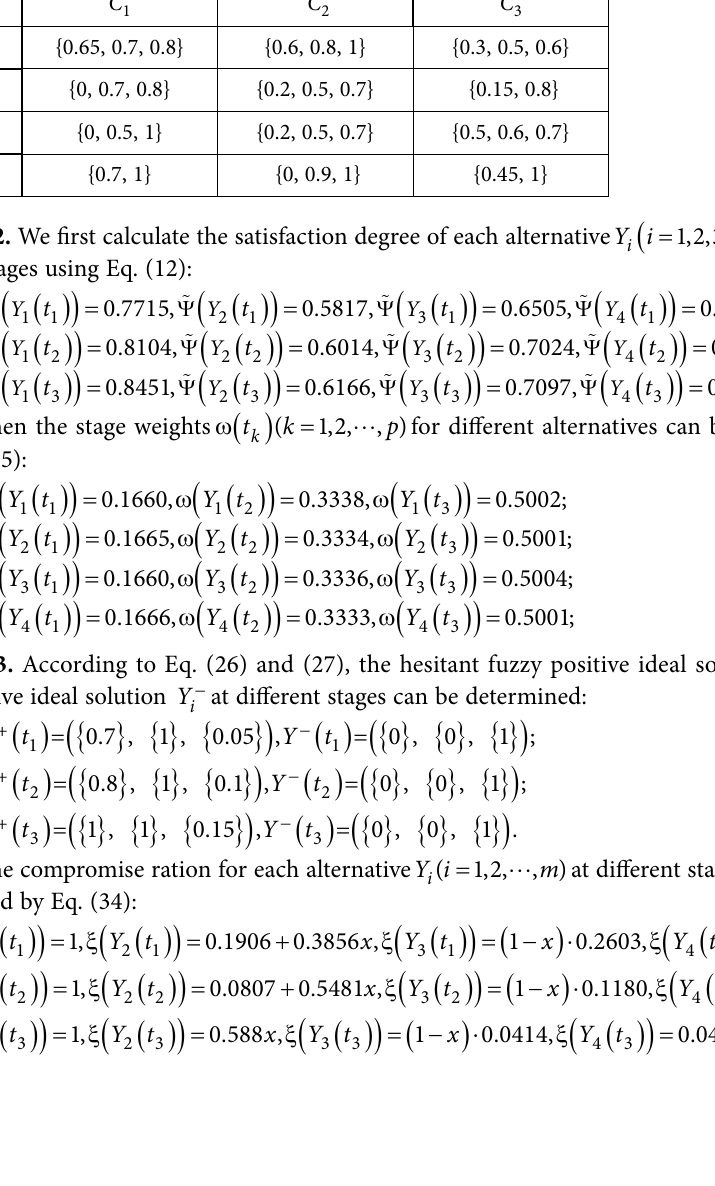
Table 4. Hesitant fuzzy decision matrix D ( t 3 ) C 1 C 2 C 3 Y